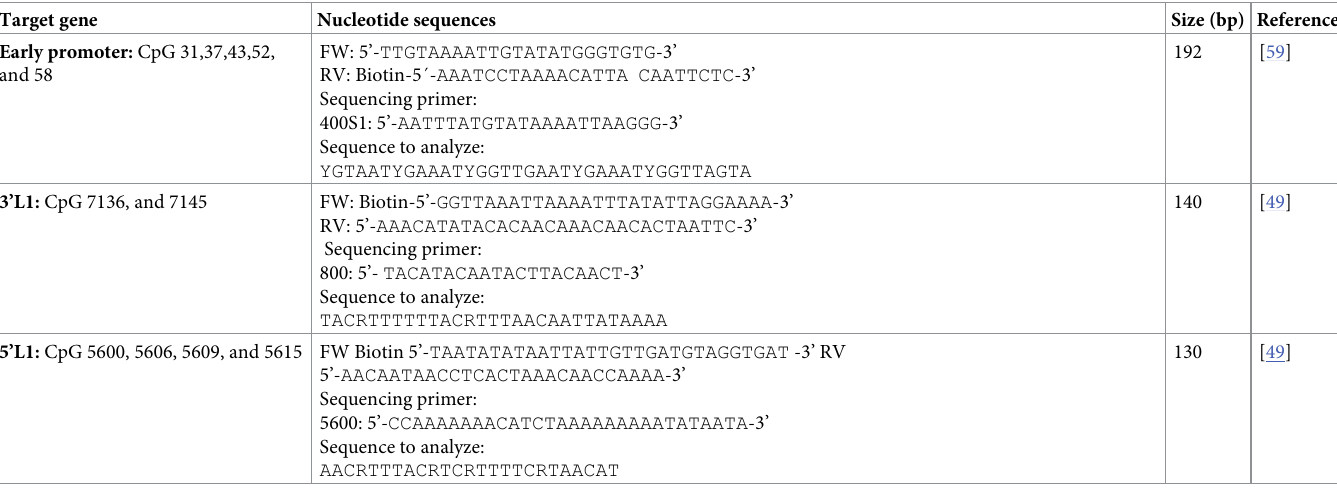
Table 1. The sequences of primers used in the present study. Target